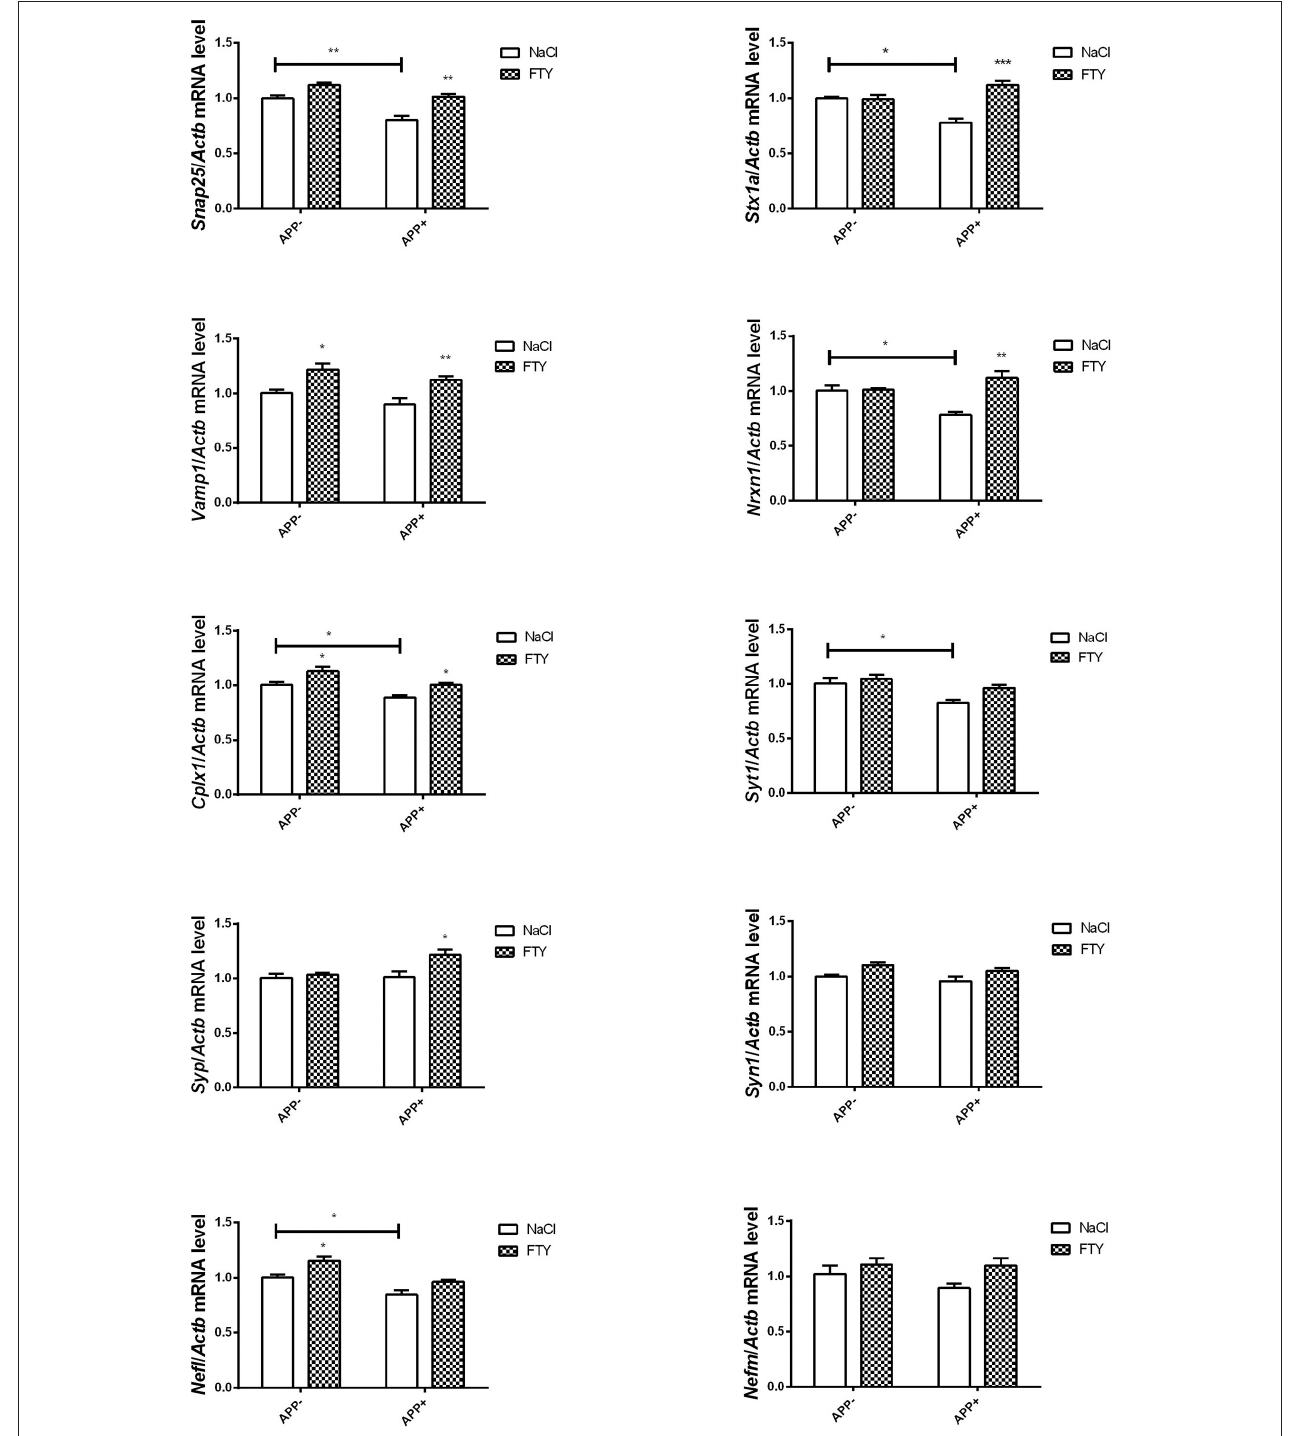
FIGURE 4 | Levels of mRNAs coding for synaptic proteins in 12-month-old hippocampus: effect of A β PP and FTY720. Levels of mRNAs measured with real-time PCR in the hippocampus of 12-month-old (old adult) mice as described in Materials and methods. mRNA levels in A β PP-expressing mice were compared with control animals that did not inherit the transgene. Effect of FTY720 administration was assessed against vehicle-treated animals in each group. Snap25 , synaptosomal-associated protein, 25kDa; Stx1a , syntaxin 1A; Vamp1 , vesicle-associated membrane protein 1; Nrxn1 , neurexin 1; Cplx1 , complexin 1; Syt1 , synaptotagmin 1; Syp , synaptophysin; Syn1 , synapsin 1; Nefl , neurofilament light; Nefm , neurofilament medium; APP − , animals without V717I A β PP transgene; APP + , mice expressing V717I A β PP transgene. * p < 0.05; ** p < 0.01; *** p < 0.001 vs. corresponding controls, two-way ANOVA followed by Tukey’s post-hoc test (horizontal bars: effect of A β PP; significances marked over FTY720 values: effect of FTY720 treatment within each animal group). n = 3–6, measured in triplicate ( n = 7–14 for Cplx1 , Syp , Syn1 , Vamp1 , and Nefl ) ± SEM.